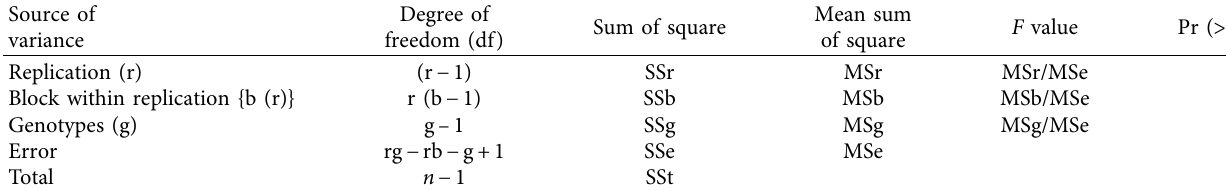
Table 2: Analysis of variance for alpha-lattice design.